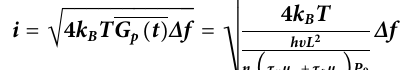
TABLE 1 | The amplitude and RMS noise ofthe time domain signal of the antenna elements and the array detector. Antenna